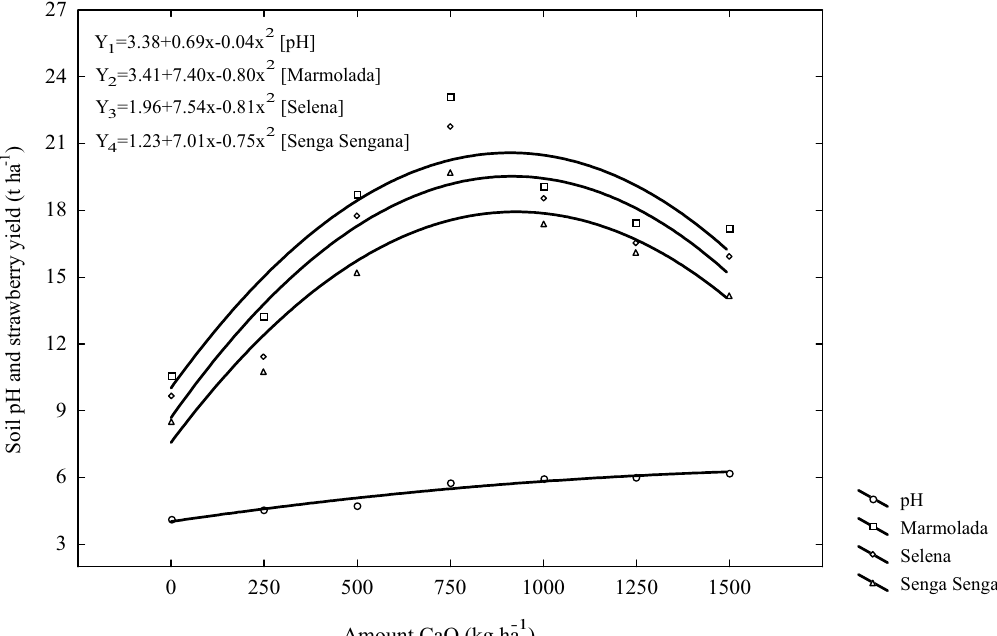
Fig. 2 – Influence of soil pH changes on